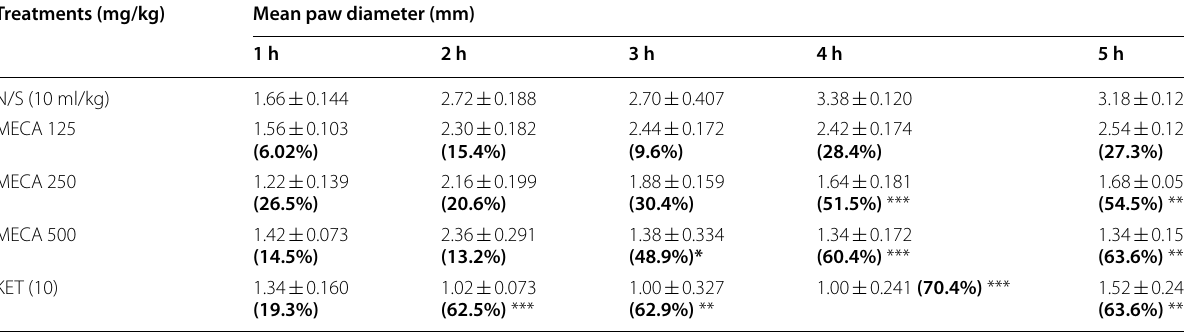
Values were analysed using repeated-measures ANOVA followed by Bonferroni post hoc test and presented as mean MECA, methanol leaf extract of Culcasia angolensis ; N/S, normal saline. Figures in parentheses (bold) represent percentage inhibition of inflammation (paw oedema) * p 0.05, ** p 0.01, *** p < 0.001 related to the control group. n ≤ ≤